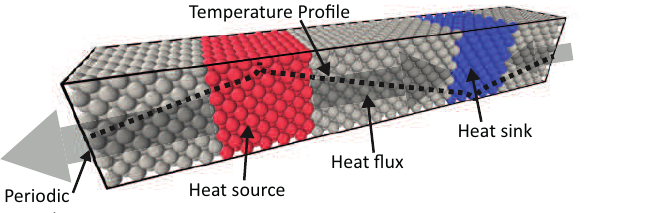
Figure 4. Schematic representation of the chosen system for steady state NEMD simulations. The heat source and sink are coupled to different temperatures with a damping constant of 100 fs. This will induce a heat flux through the intermediate zone, which is weakly coupled with a damping constant of 100.000